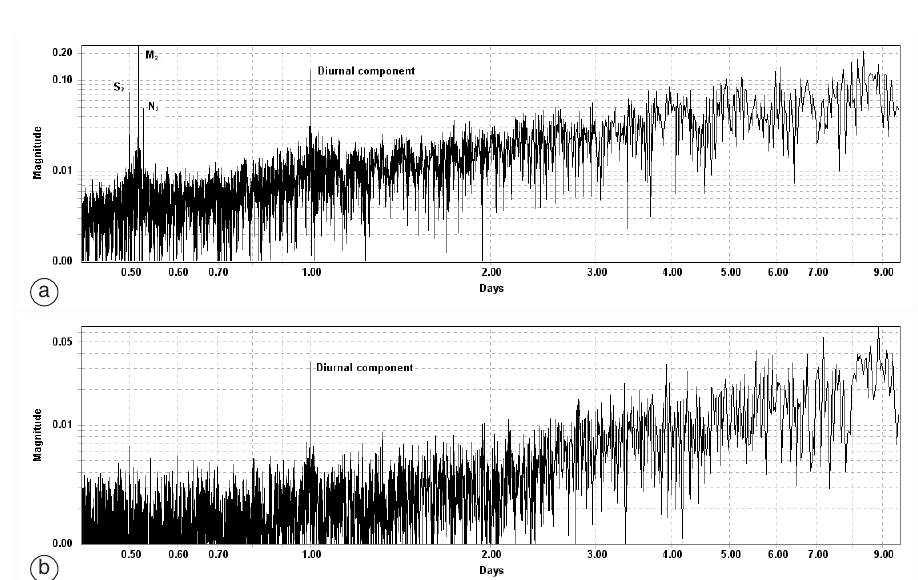
Fig. 8a,b. Spectral analysis of Tilt and Te signals recorded by BAI station over the years 1998-2001 (210384 data points with a sampling frequency of 6 cph). Thermal components given by the two signals are to be ascribed to the thermoelastic ground deformation. The semi-diurnal components, not given by the Te signal, are related to the influence of sea tide in the Baia Gulf but also to that of earth tide components: a) FFT of Tilt data ( µ rad) and (b) FFT of the Te data